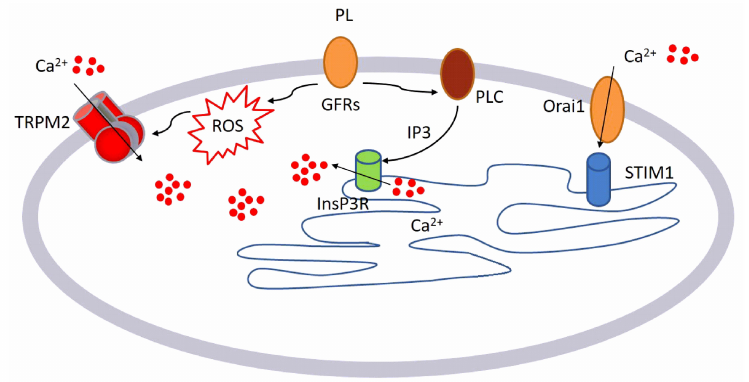
Figure 9. Diagram depicting the mechanism of action of PL on bEND5 endothelial cells, as characterized in the